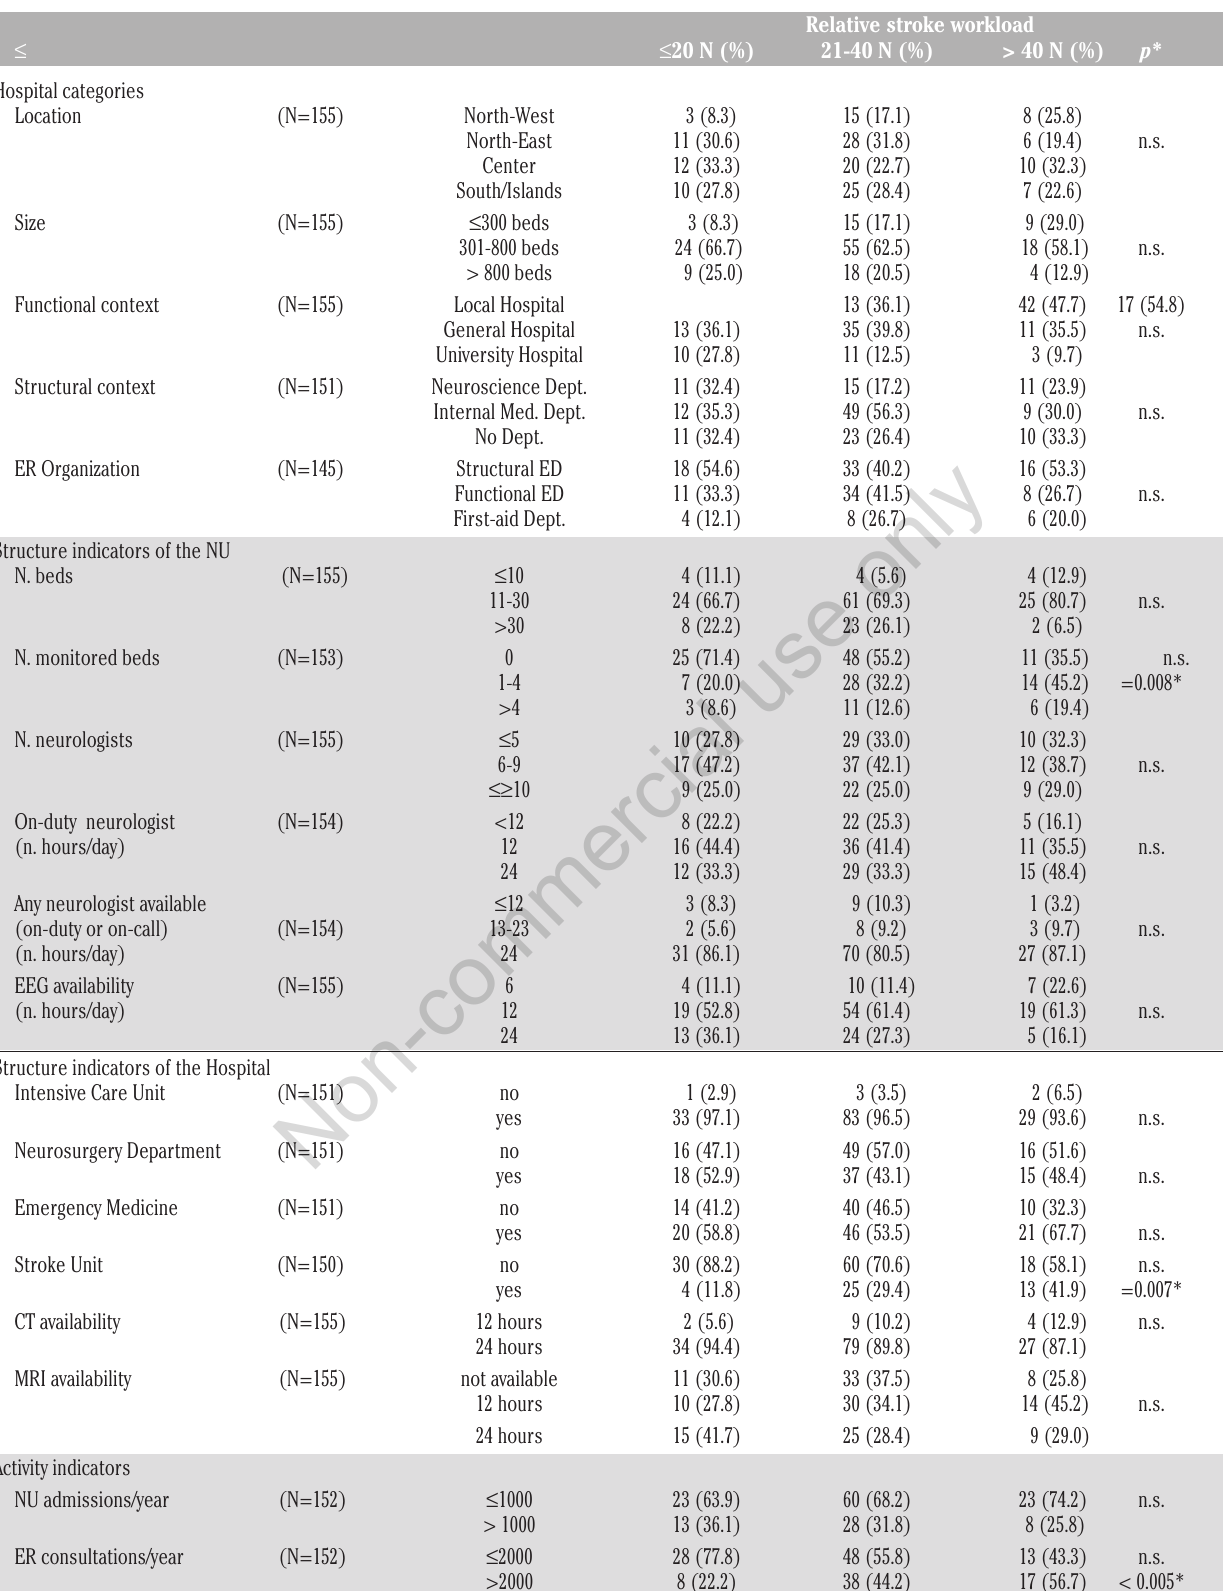
Relative stroke workload